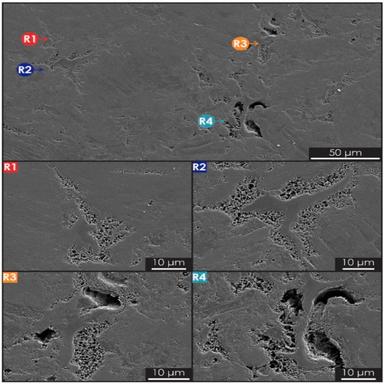
SEM micrographs taken from a polished surface of CGB. Region 1 (R1) shows examples of partially infiltrated pores. Region 2 (R2) shows examples of pores fully infiltrated by the carbon foam. Region 3 (R3) shows examples of both partially filled pores and fully infiltrated pores. Region 4 (R4) shows an example of fully filled pores around a filler particle.